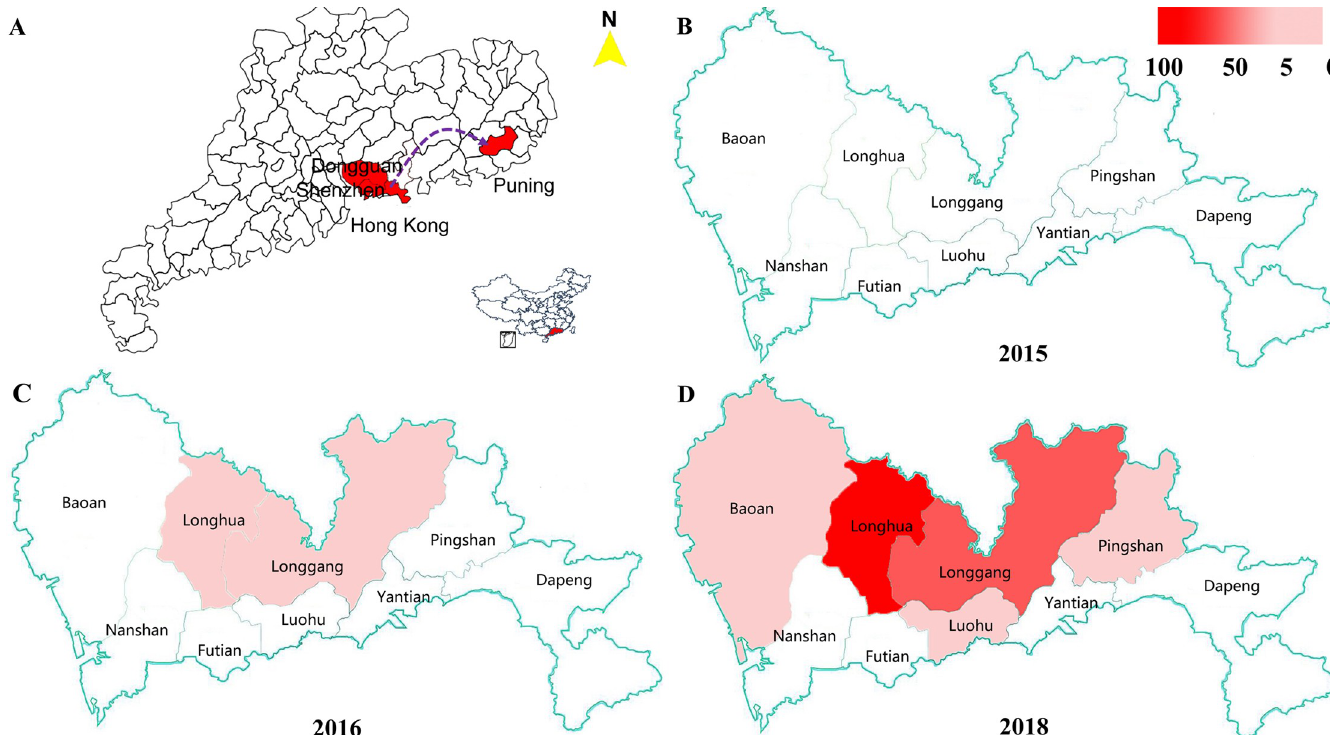
Fig 3. Fast expanding and distribution of red B . straminea studies in Shenzhen. ( A ) maps of RBS in Guangdong province and Hong Kong area in China. ( B ) 2015 ( C ) 2016 ( D ) 2018. Red area indicates occurrence of RBS and relates to the highest density in district. These maps were created using ArcGIS.